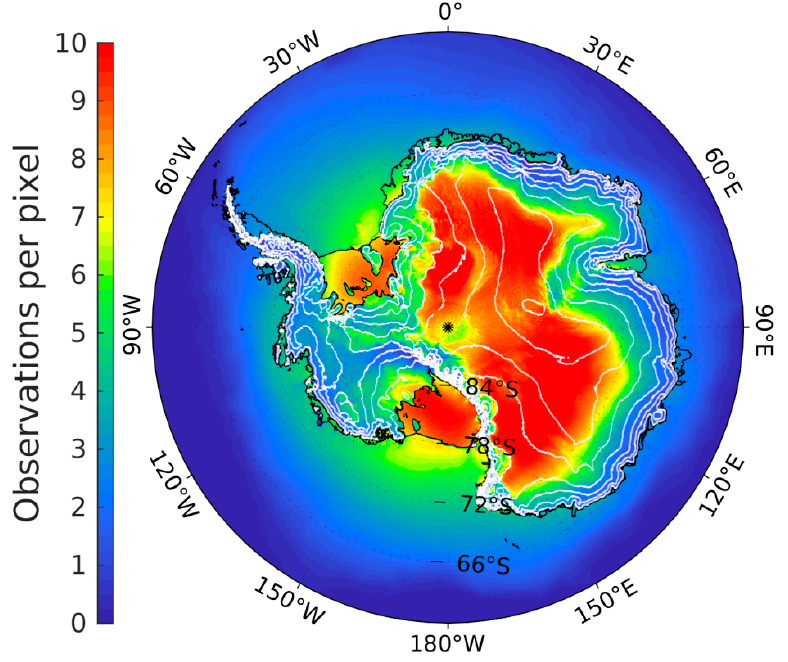
Figure 4. Mean daily coverage 2002–2017 of cloud-free pixels (topography as isolines every 500 m). Monthly means of the IST were calculated from the daily averages. In order to quantify the katabatic warm signatures, an anomaly was computed as the temperature difference between a region affected by the katabatic wind and a reference region, where no or only weak warming effects due to katabatic winds or surges are present.